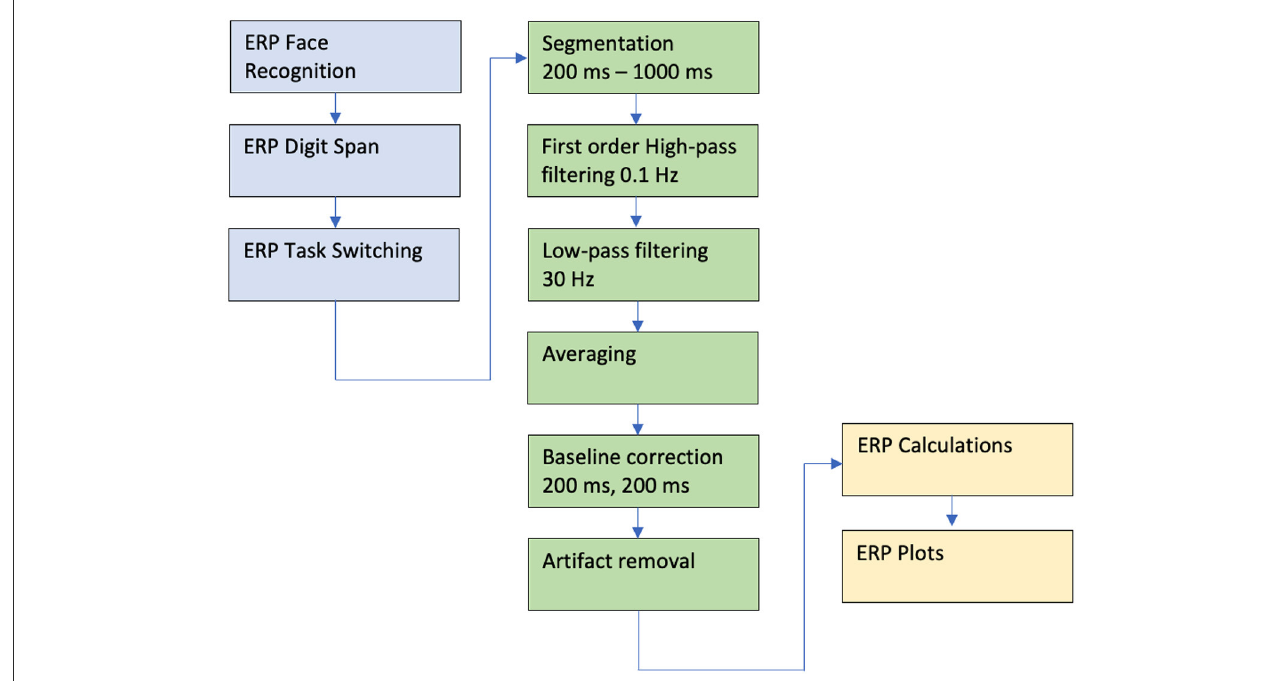
FIGURE2 Data analysis pipeline for the ERP experiments. For detail see the text.